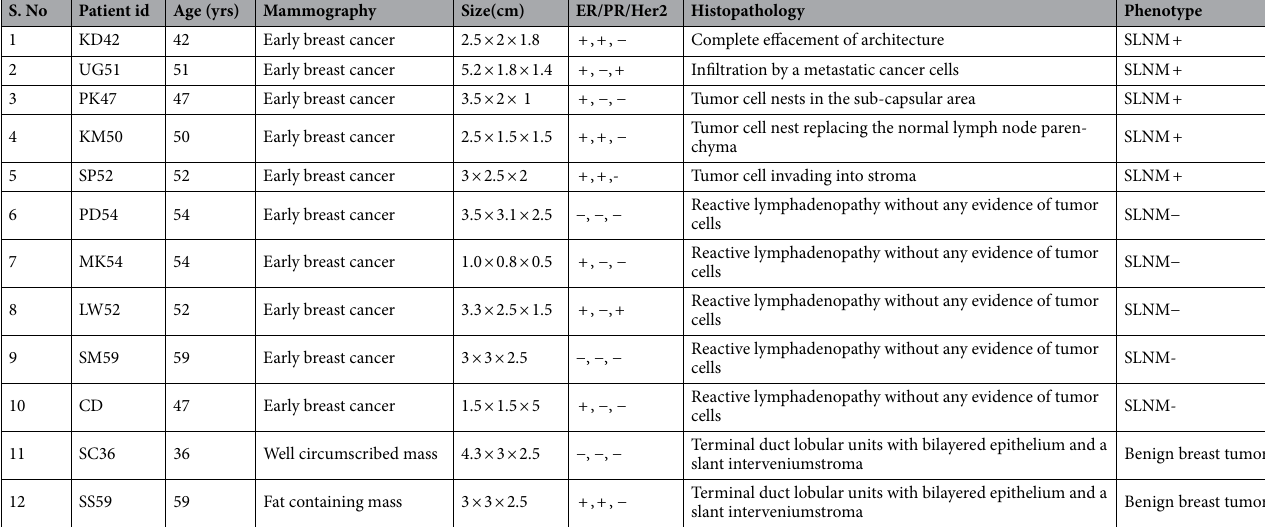
Table 1. Clinical profile of patients recruited in the discovery phase of the iTRAQ experiment.